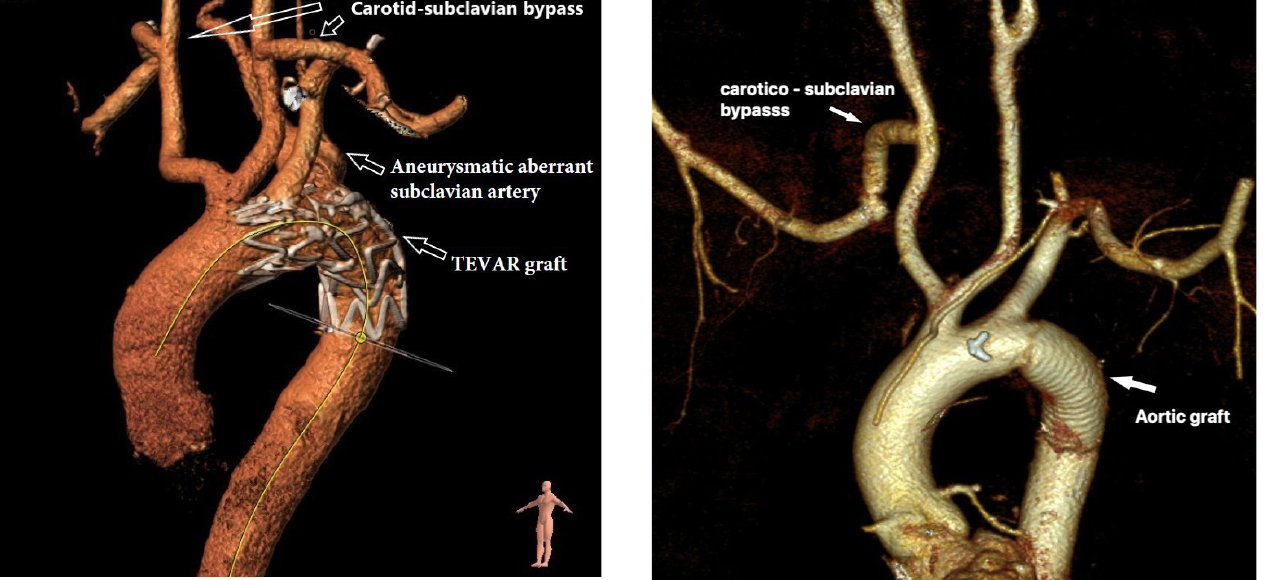
Fig. 2 - Postoperative control three-dimensional reconstructed computed tomography angiography of open aberrant right subclavian artery resection/ligation and right carotid-subclavian artery bypass.